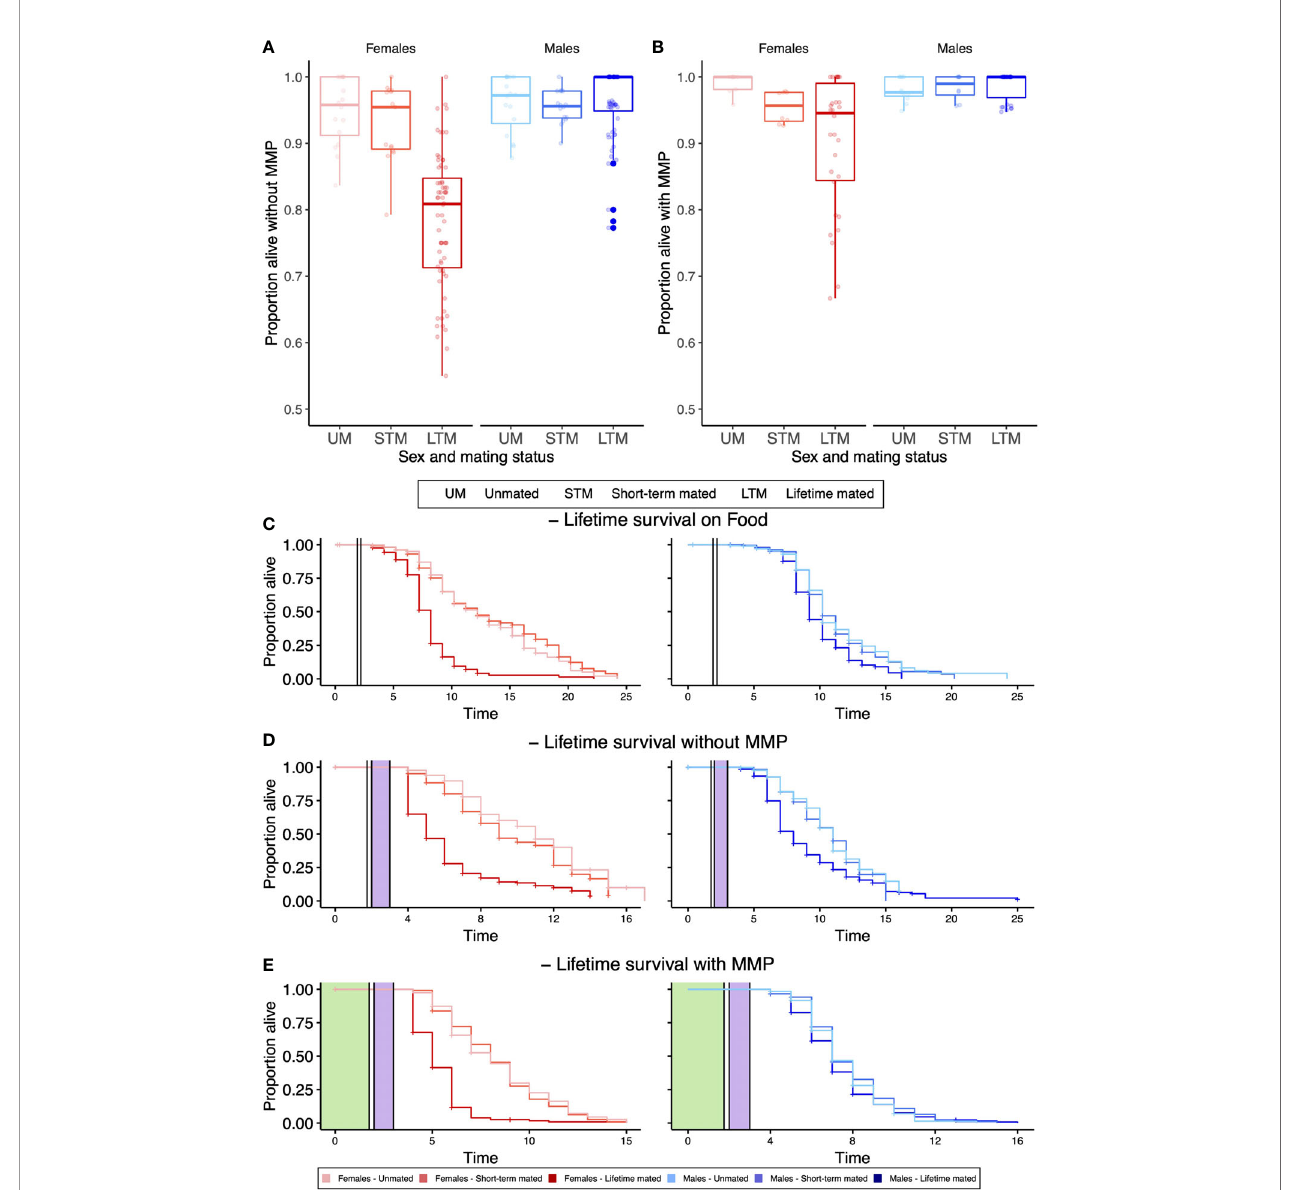
FIGURE 1 | Survival of different sexes and mating treatments after 24-h pathogen infection (A, B) and lifelong (C – E) . (A) Without MMP, females suffer more from mating than males do, while males survive better overall. (B) With MMP, females are suffering more from mating, while males survive better overall. (C) When only ever being exposed to food (in white), lifetime mated females survive worse than any other females, while only lifetime mated males survive worse than short-term mated males. (D) After pathogen infection (in purple) without MMP, lifetime mated females survive worse than short-term mated females, which survive worse than unmated females. Male survival was not affected by mating, while males live overall longer than females do. (E) After pathogen infection with MMP (in green), lifetime mated females survive worse than short-term mated females, while males are not affected by mating. (A, B) Boxplots display four biological replicates and three or four technical replicates with 50 worms on each plate. (C – E) Each curve represents the Kaplan – Meier survival estimate for three or four technical replicates and four or fi ve biological replicates with 20 (C) or 10 worms (D, E) on each plate. Vertical lines indicate when worms were transferred to a new bacterial